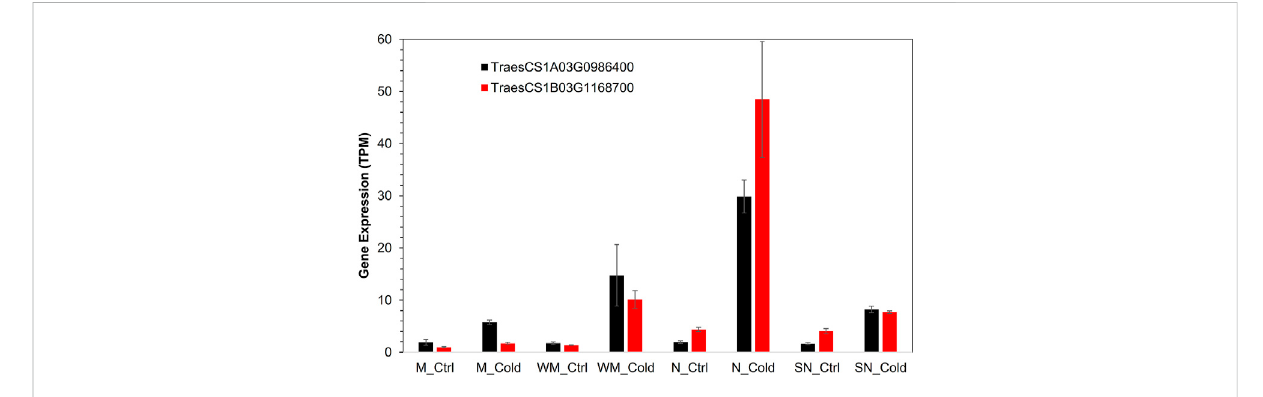
FIGURE 5 Expression of two homoeologs of COR413-TM1 gene in different experimental conditions.